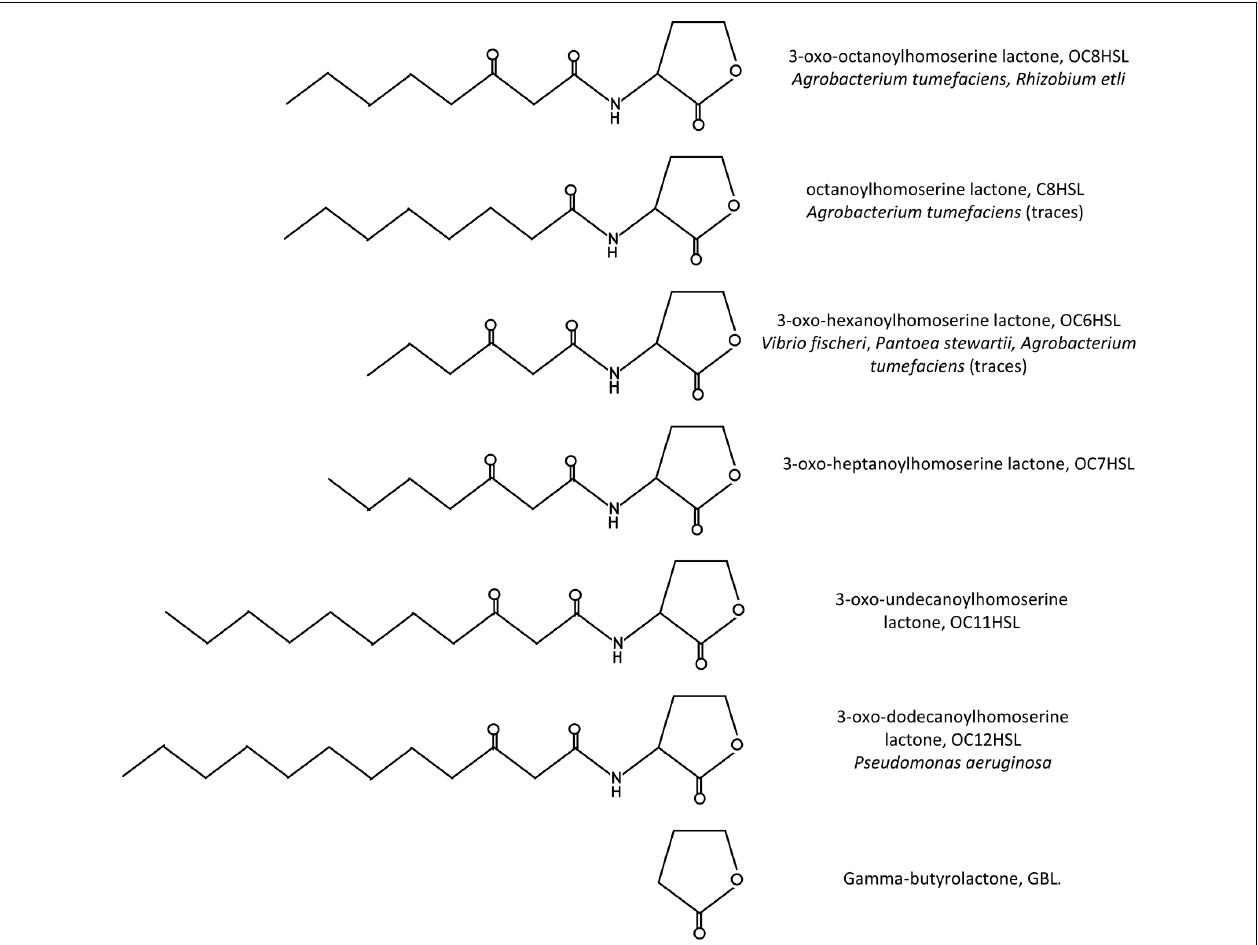
FIGURE 1 | Structures of the QS signals mentioned in this review. In parallel are indicated the full name of the molecule, its abbreviation as well as some bacterial species known to produce it.